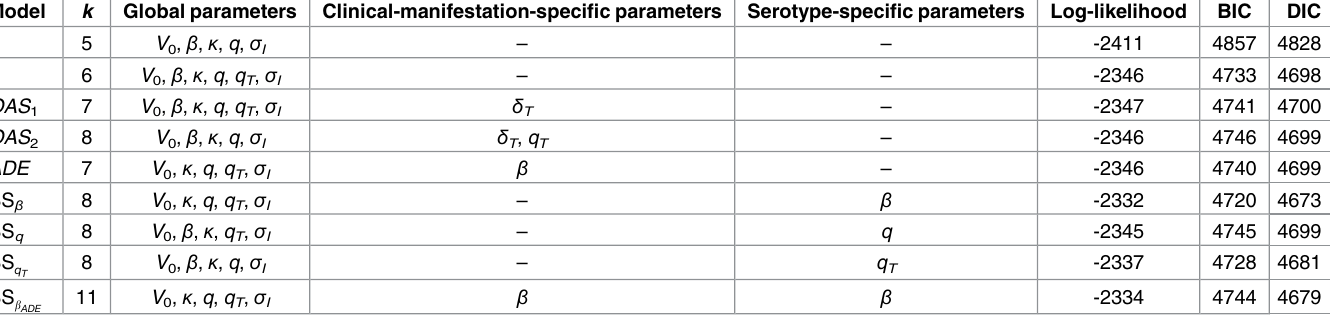
Table 2. Models considered. Column k lists the number of free parameters. Globalparametersare shared across all individuals, regardless of clinicalmani- festation or infecting serotype. Also shown are the median log-likelihood values, BIC and DIC values for all models considered. Model k Global